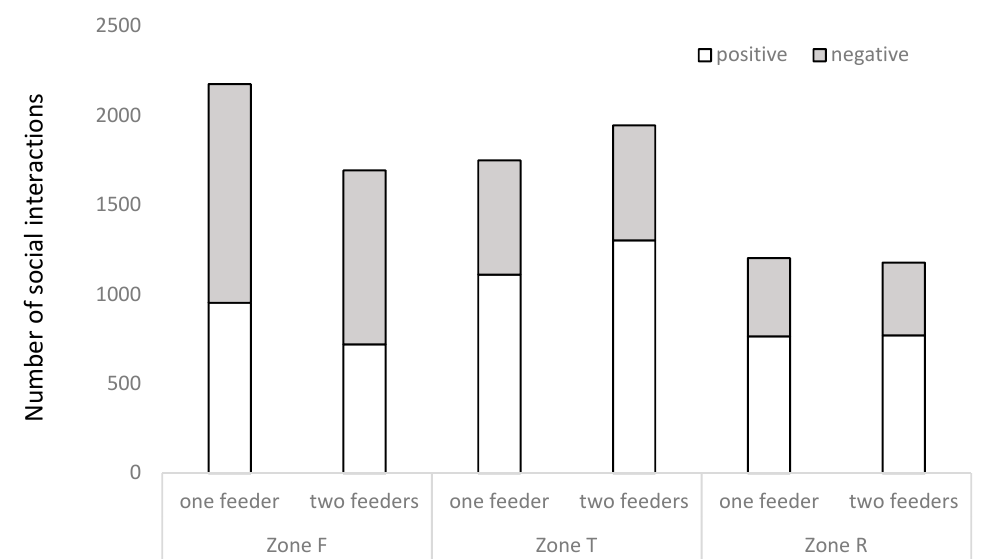
Figure 9. Presence of positive and negative social interactions in relation to the zone of the pen (where Zone F is the feeding area, Zone T is the intermediate area, and Zone R is the resting area) when pens had one feeder or two feeders.